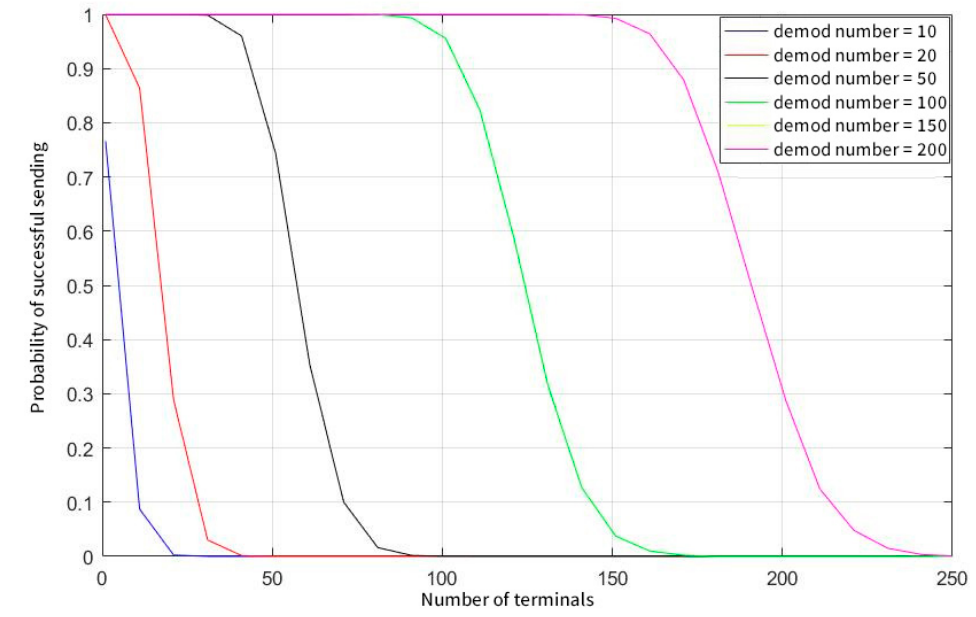
Figure 8. Probability of successful sending when sending interval of terminals equals 1.